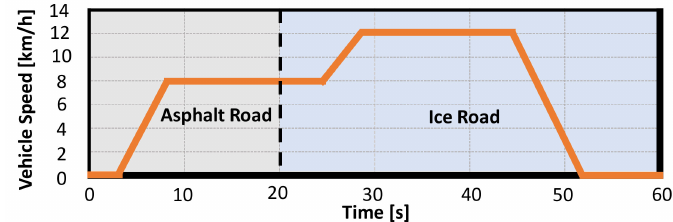
Figure 11. Driving cycle used in anti-slip real-time